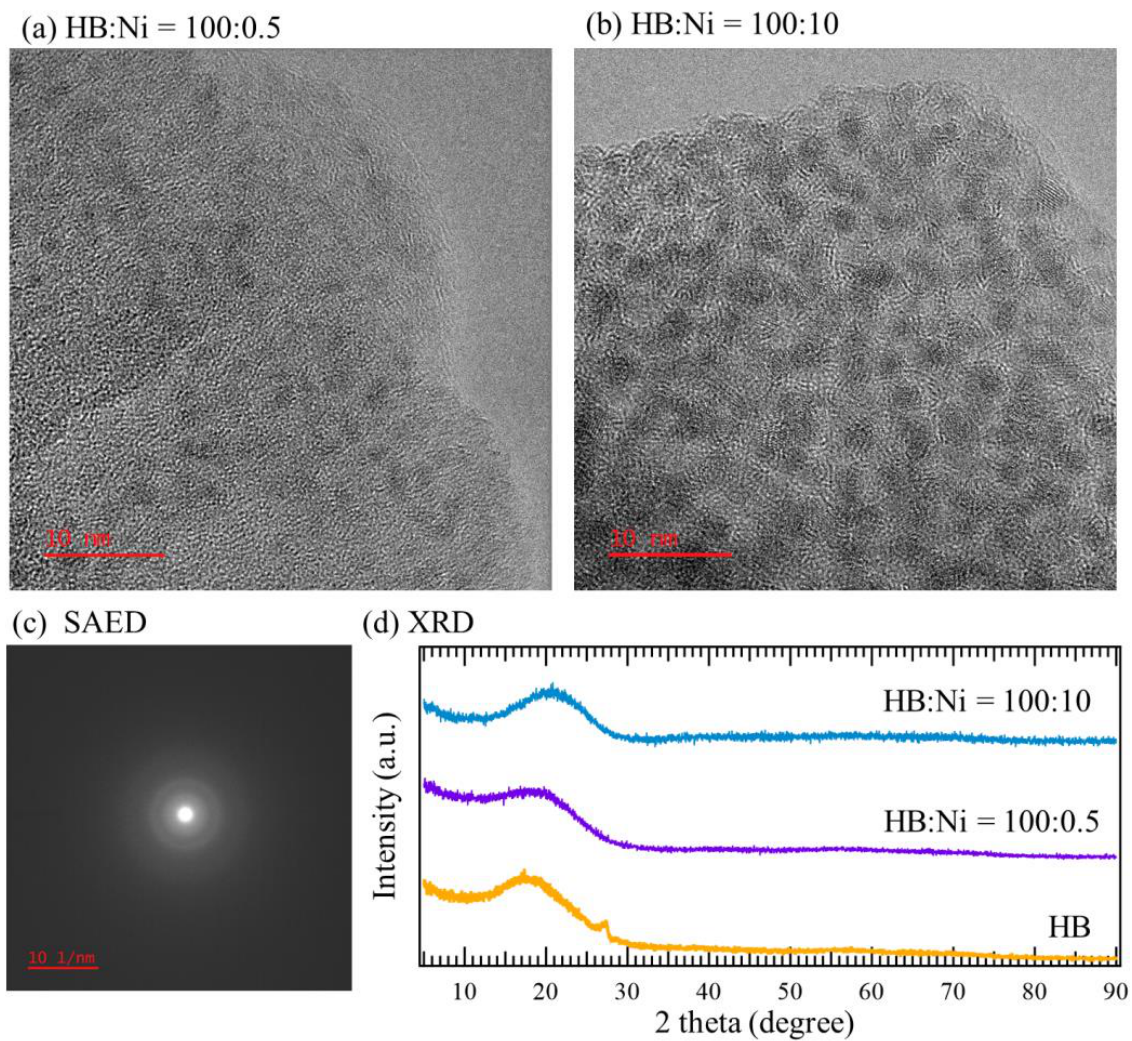
Figure 5. TEM images SAED pattern and XRD patterns. ( a ) TEM images of HB:Ni = 100:0.5, and ( b ) HB:Ni = 100:10. ( c ) SAED pattern simultaneously obtained with the TEM image shown in panel b. ( d ) XRD patterns of HB, HB:Ni = 100:0.5, and HB:Ni = 100:10 (a Kapton capsule was used as a cover of the sample to prevent the exposure of the sample to the atmosphere). The XRD pattern of HB shows a small peak at 27 ° , which is considered to be originated from the stacking of some of the sheets.